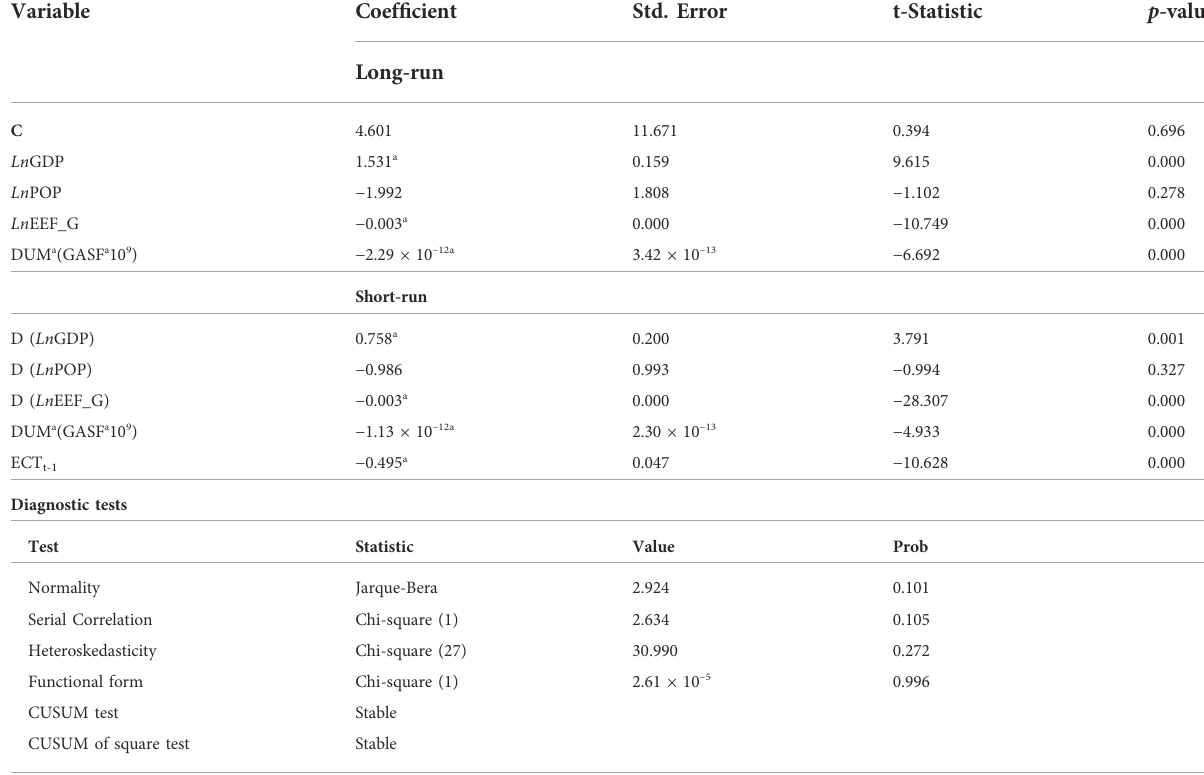
TABLE 11 ARDL results for the Gas power plant (dependent variable =